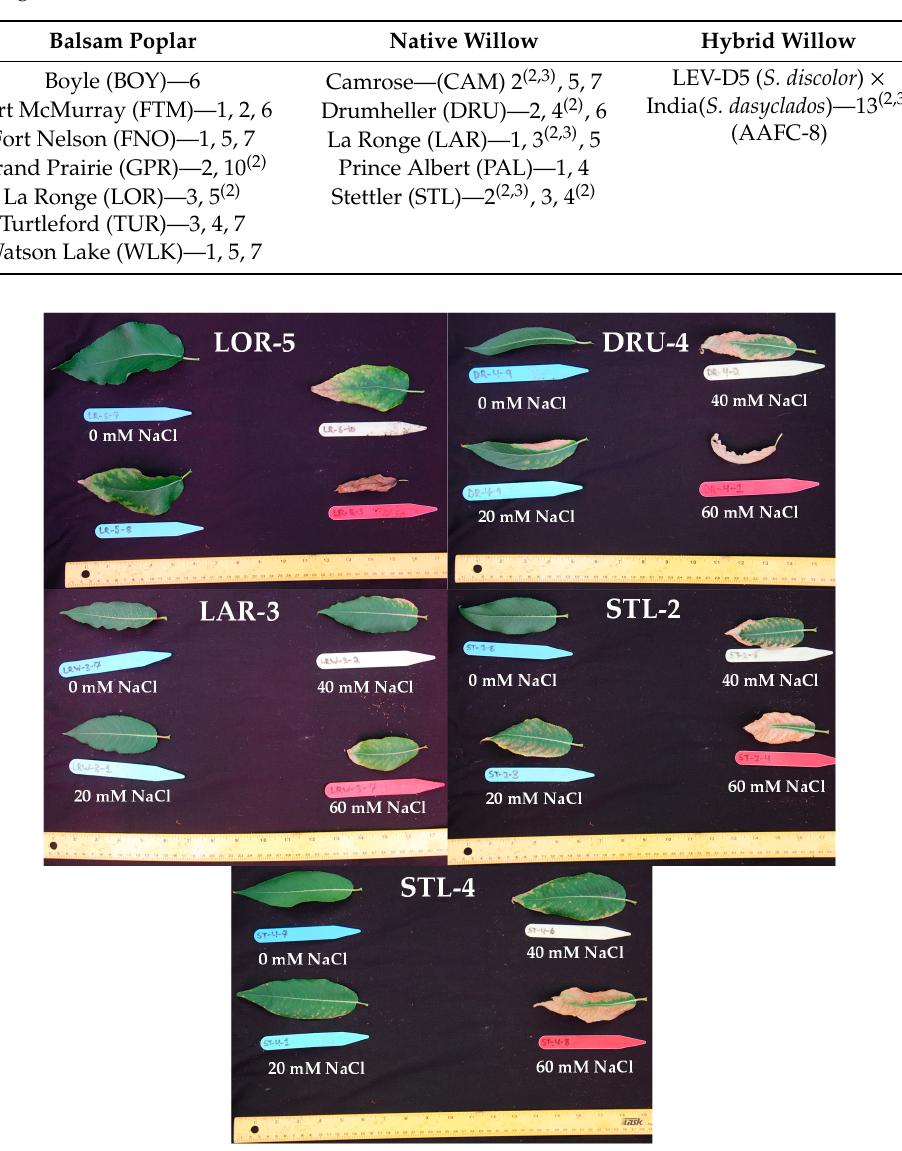
Figure A1. Leaves collected from genotypes LOR-5, DRU-4, LAR-3, STL-2, and STL-4 after 12 weeks of salinity treatment.